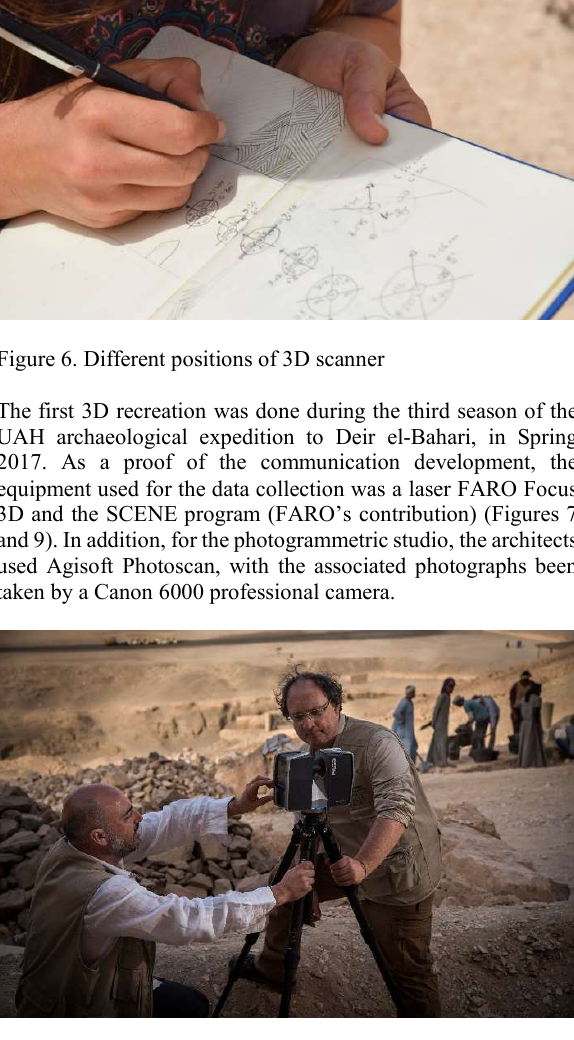
Figure. 7. Placement of the laser scanner.